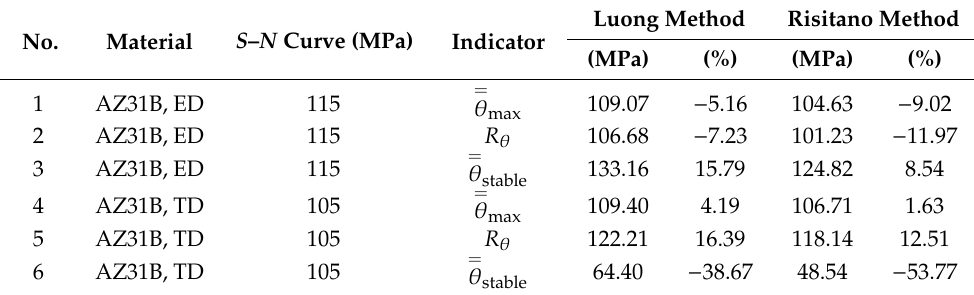
Summarized results of fatigue limit obtained by using the Luong method and the Risitano